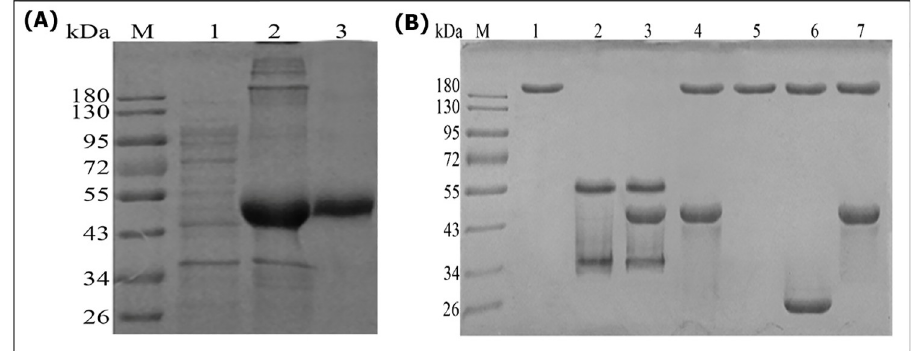
Fig 2. A : Purification of Recombinant protein. M: Protein molecular weight Marker; Lane 1: Supernatant of recombinant E . coli lysis; Lane 2: Inclusion body from recombinant E . coli ; Lane 3: Purified recombinant protein. B : Tsp-GILT exhibits thiol reductase activity in vitro. M, protein molecular weight marker; Lane 1: Rabbit IgG treated without DTT at pH 7.0 as negative control; Lane 2: Rabbit IgG treated with 50 mM DTT at pH 7.0 as positive control; lane 3:Rabbit IgG incubated with Tsp-GILT (activated by 10 mM DTT at pH 4.5); Lane 4:Rabbit IgG incubated with Tsp-GILT (without DTT at pH 4.5); Lane 5: Rabbit IgG incubated without Tsp-GILT, with 10 mM DTT at pH 4.5; Lane 6: Rabbit IgG incubated with pET32a tag protein (treated with 10 mM DTT at pH 4.5); Lane 7: Rabbit IgG incubated with Tsp-GILT (treated with 10 mM DTT at pH 7.0).